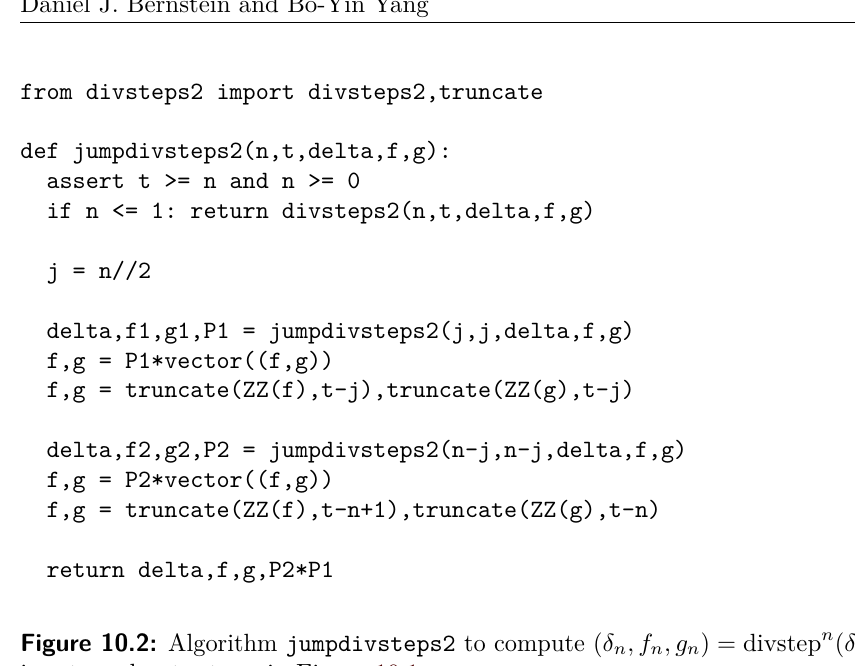
Figure 10.2: Algorithm jumpdivsteps2 to compute ( δ n , f n , g n ) = divstep n ( δ, f, g ). Same inputs and outputs as in Figure